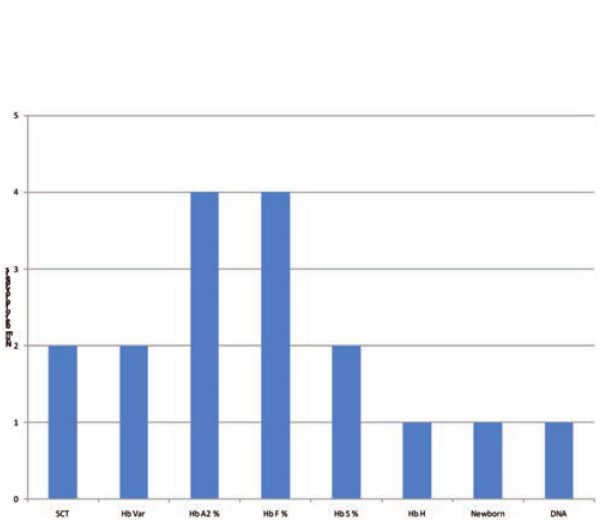
Figure 2. EQA provision for tests for the diagnosis of haemoglo- bin